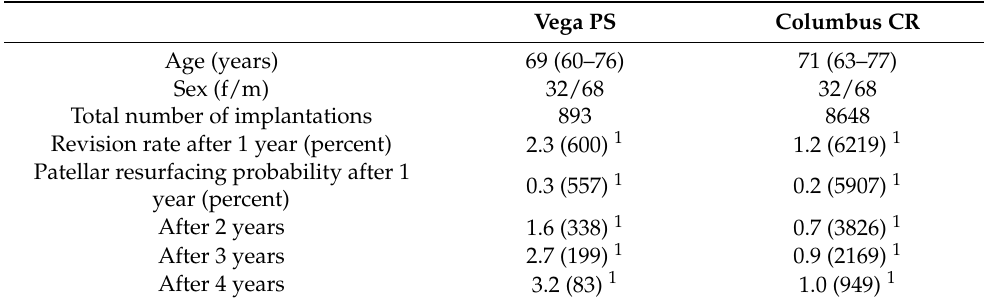
Table 1. Information about Vega posterior-stabilized (PS) and Columbus cruciate-retaining (CR) prostheses from the German Arthroplasty registry (EPRD), representing cohort 2 [1]. Vega PS Columbus